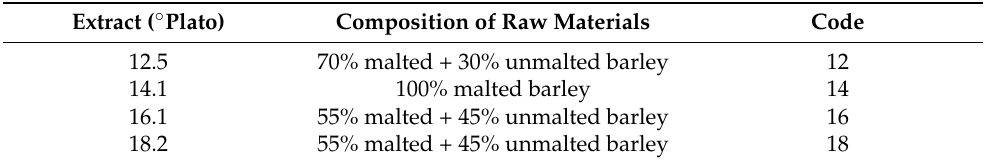
Table 1. Coding of hot trub